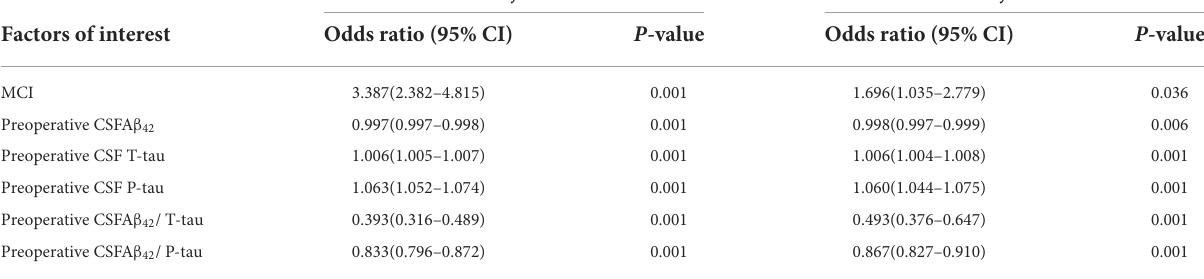
TABLE 3.1 Logistic analysis for risk factors of POD